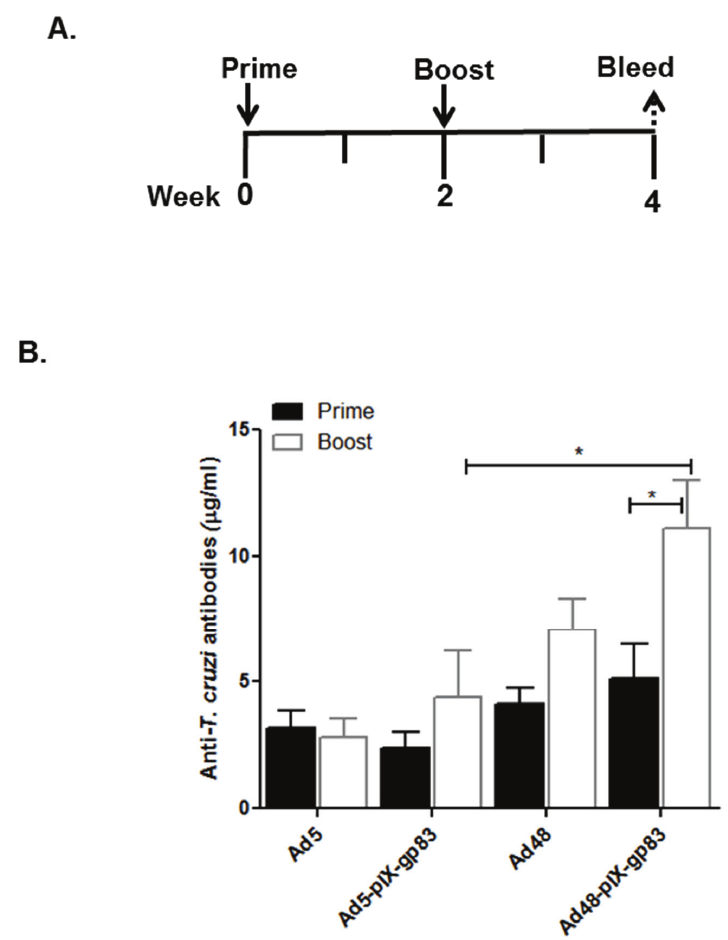
Figure 6. Cont . Figure 6.